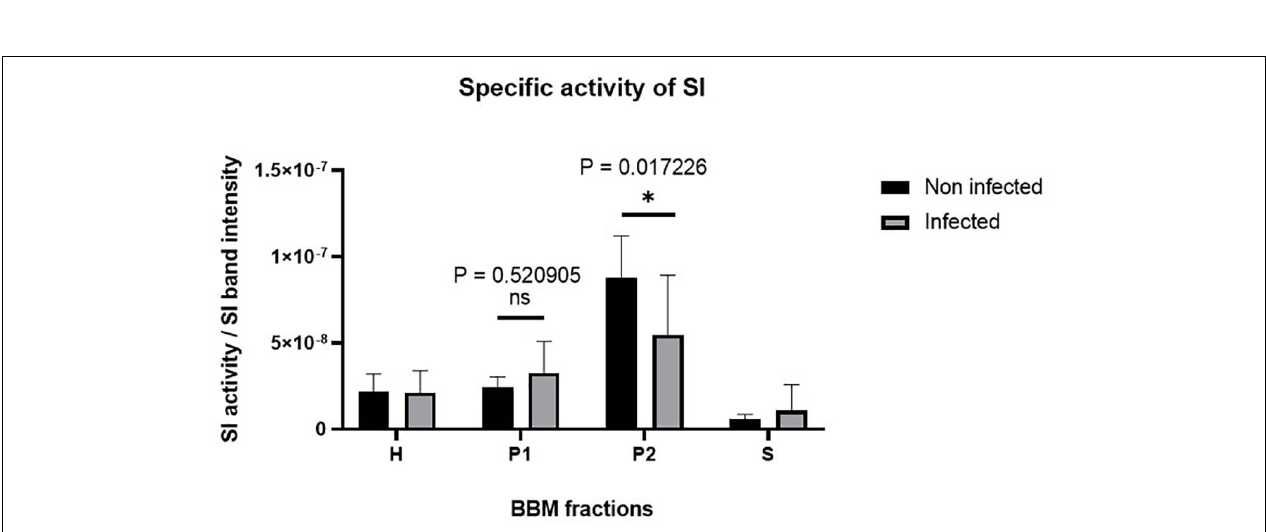
FIGURE 4 | The specific activity of sucrase–isomaltase (SI) is substantially reduced in Caco-2 cells upon Staphylococcus aureus Newman infection. Caco-2 cells were infected or not infected with S. aureus Newman. Forty-eight hours post-infection, Caco-2 cellular homogenates (H) were partitioned into intracellular and basolateral membranes (P1), brush border membranes (P2), and vesicular and soluble fraction (S). Specific activity of SI in the different membrane fractions was analyzed and found to be significantly reduced in the P2 fraction in infected Caco-2 cells as compared with the non-infected. ns, non-significant; and ∗ p ≤ 0.05 using one-tailed Student’s t -test. Data represent mean ± SEM of three independent experiments with samples in duplicates or triplicates.